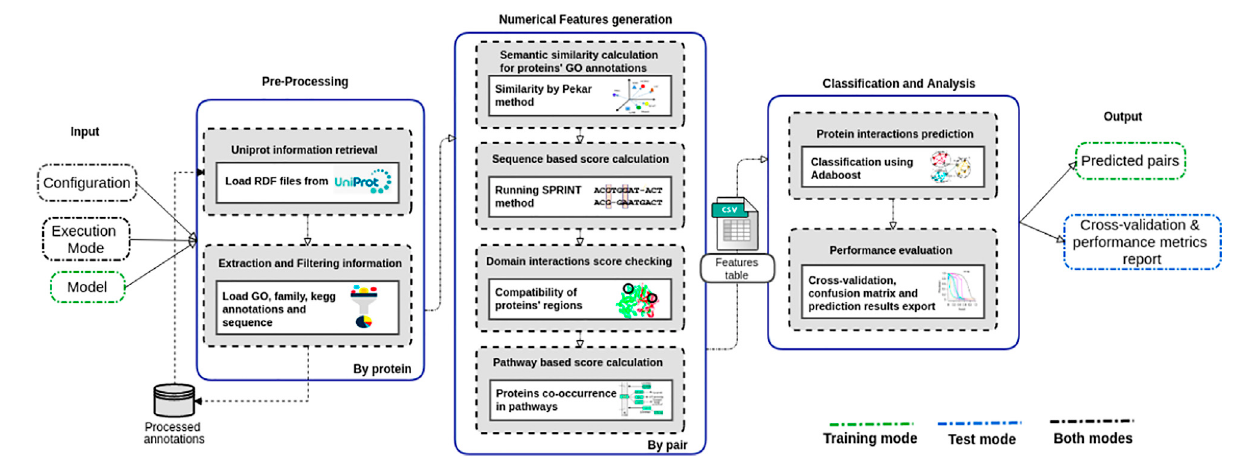
FIGURE 1 | Steps of the PredPrIn architecture: (i) Preprocessing; (ii) Numerical feature generation, and (iii) Classi fi cation and analysis. The preprocessing step retrieves protein information from the UniProt database, and automatically parses and fi lters them to build a knowledge base of processed features. The numerical feature generation step uses this knowledge base to distribute the correct inputs for the execution of the four detection methods and then generates a matrix of scores organized according to these methods ’ results. This matrix is used in the classi fi cation and analysis step to carry out the prediction by a classi fi er implementing the boosting technique. PredPrIn may run in either training or test mode. In both modes it is mandatory ful fi lling the con fi guration fi le with the information of the datasets containingPPIsandthespeci fi cationofmodetype(trainortest).Intestmode,theadditionalinputisatrainedmodelpreviouslycomputedandthework fl owoutputisthe positively predicted PPIs. No further input is required in training mode, and its outputs correspond to the trained model, the cross-validation and performance metrics